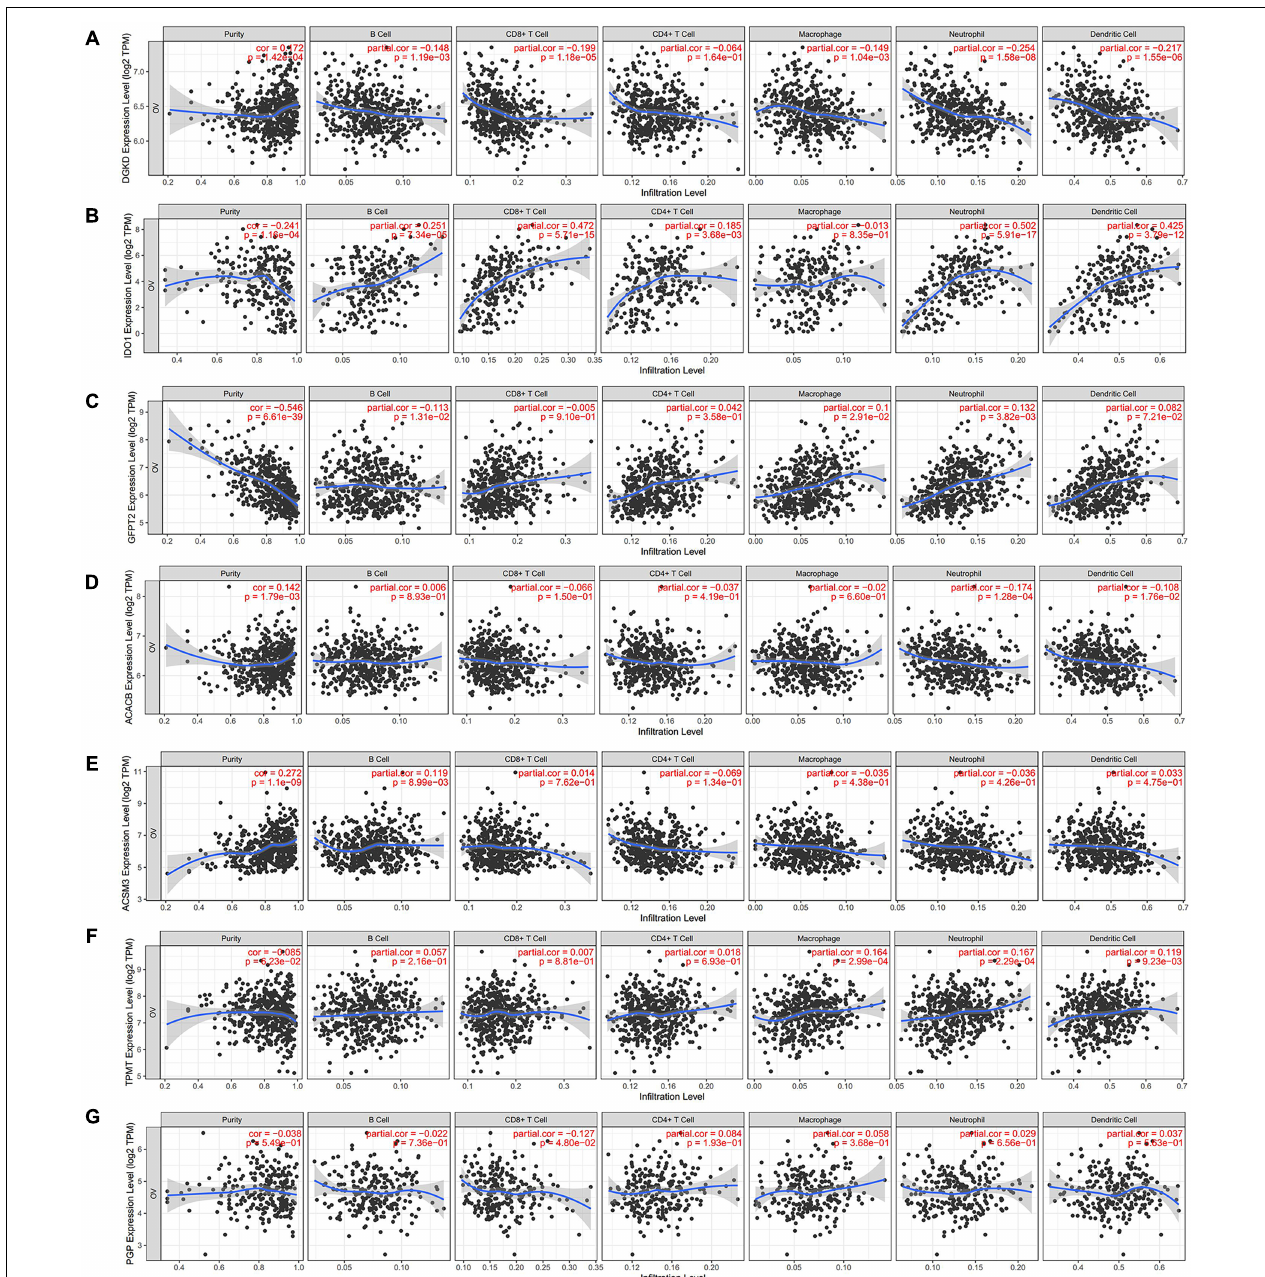
FIGURE 6 | Analysis of immune cells infiltration with seven hub genes expression in TIMER database. The correlation between the infiltration of immune cells and the expression of DGKD (A) , IDO1 (B) , GFPT2 (C) , ACACB (D) , ACSM3 (E) , TPMT (F) , and PGP (G)